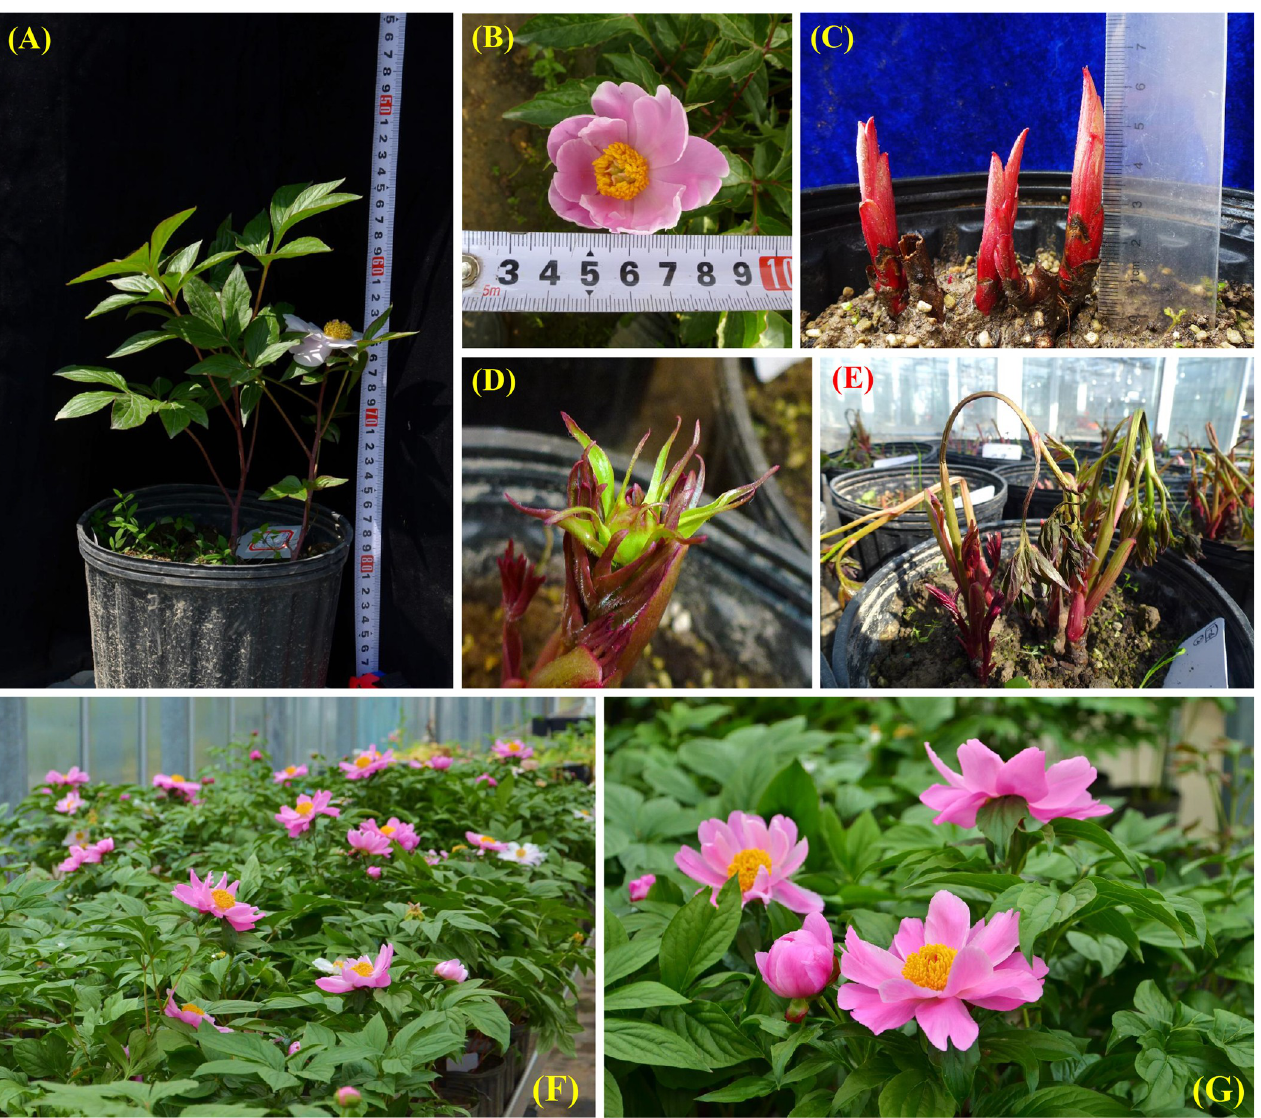
Fig 10. Sprouting, growth and flowering of potted ‘Hang Baishao’ in glasshouse. (A)-(B): the plants of ‘Hang Baishao’ accepted short chilling duration and painted by 5-azacytidine, then they were partially dwarfed and generated small and abnormal flowers; (C)-(D): immediate sprouting and early-visible flower buds of the “T. � -3” and “T. � -4” plants that were irrigated by GA 3 ; (E): fallen and withered plants of “T. � -3” and “T. � -4”; (F): the flowering landscape of ‘Hang Baishao’ treated by HA and artificial chilling in the group “T. 10- � ” in mid-February; (G): highly ornamental properties of one potted plant in mid-February in the subgroup “T. 10–2” treated by four weeks of chilling and 300 mg/L HA, which had clear commercial value as potted or cut-flower for the market of the Chinese Spring or Lantern Festival.